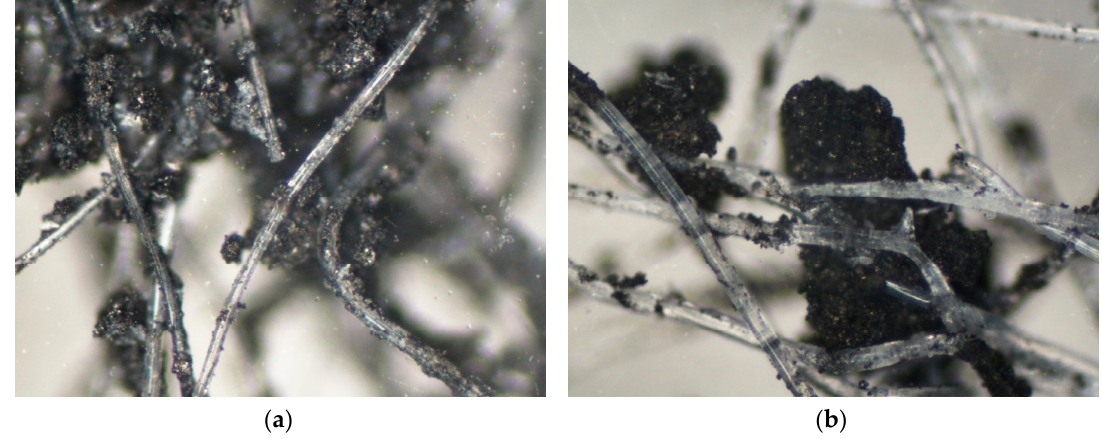
Figure 3. Optical microscope images of AC-NW composite at ( a ) 250x and ( b ) 500x magnification.